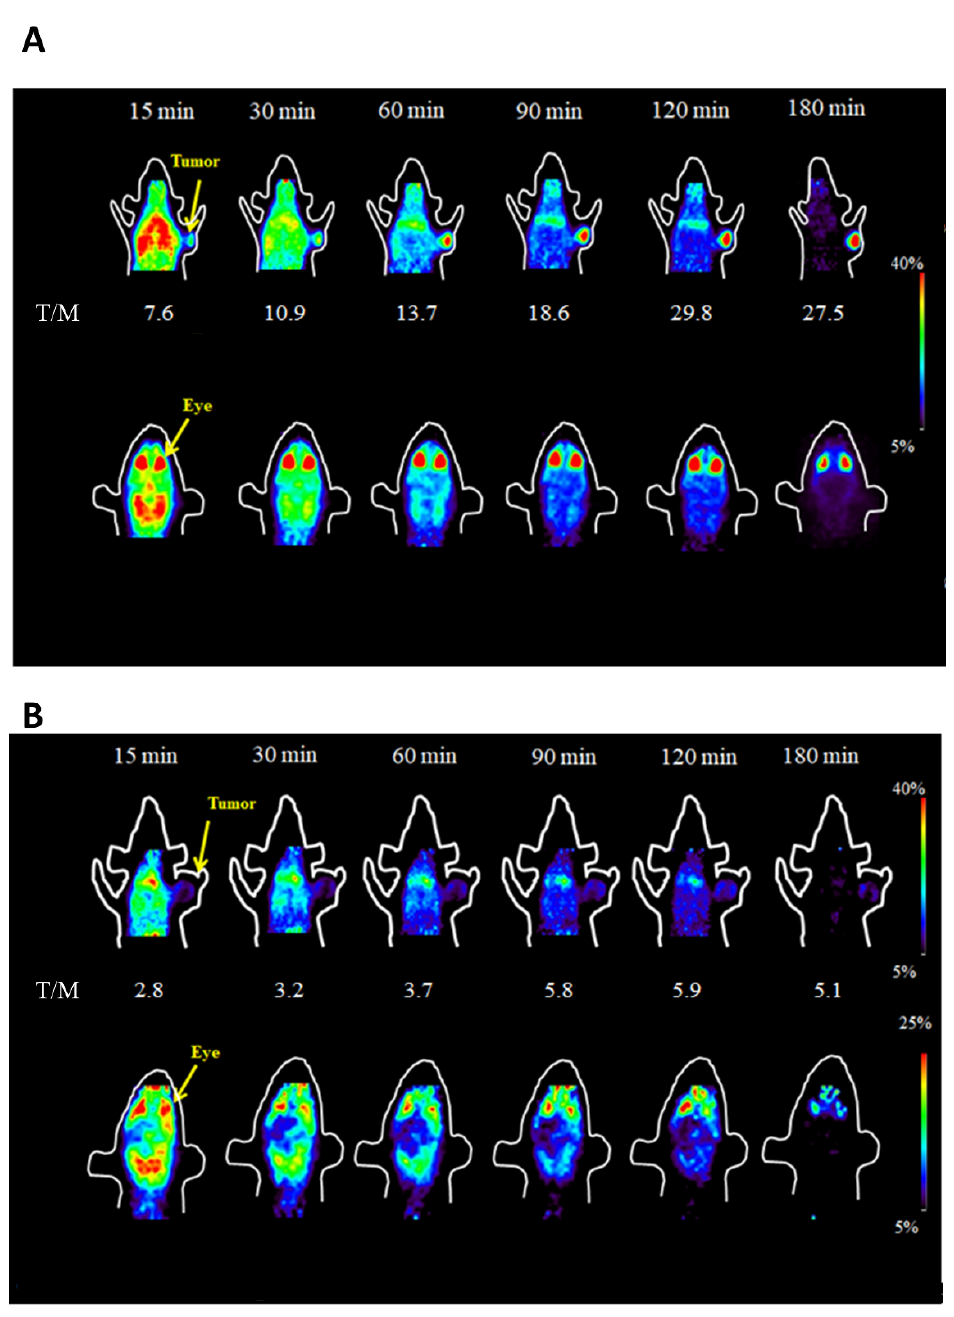
Figure 6. Representative microPET images of B16F10 tumor-bearing C57BL/c mice administered with ( A ) 18 F-FPABZA and ( B ) 18 F-FNABZA at 15, 30, 60, 120, and 180 min post-injection. The image slices covered the tumor (top) and eyes (bottom). T/M: tumor-to-muscle ratio.